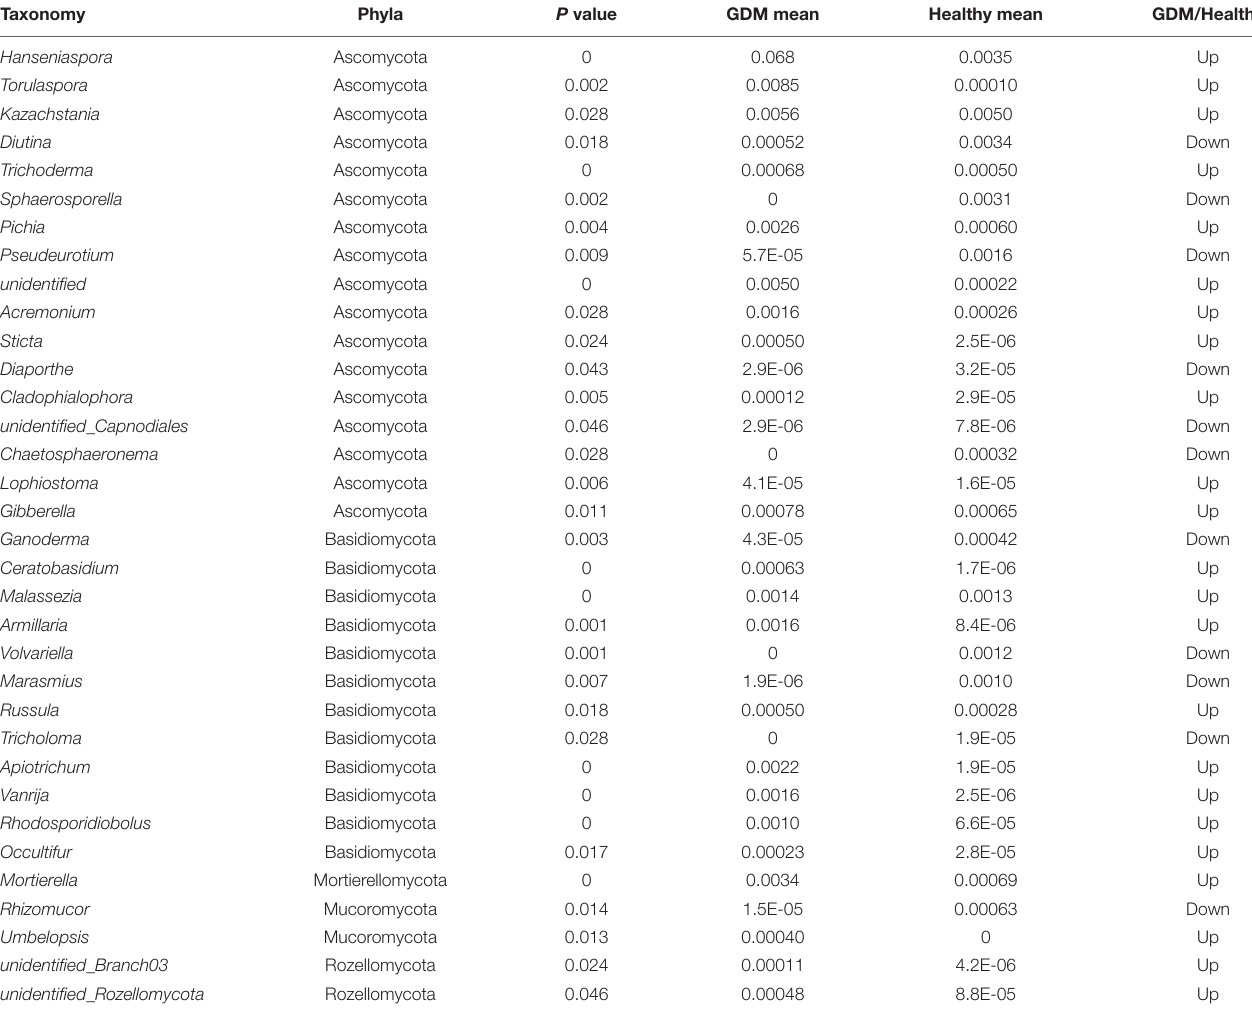
TABLE 2 | Genera that were different in the GDM and healthy